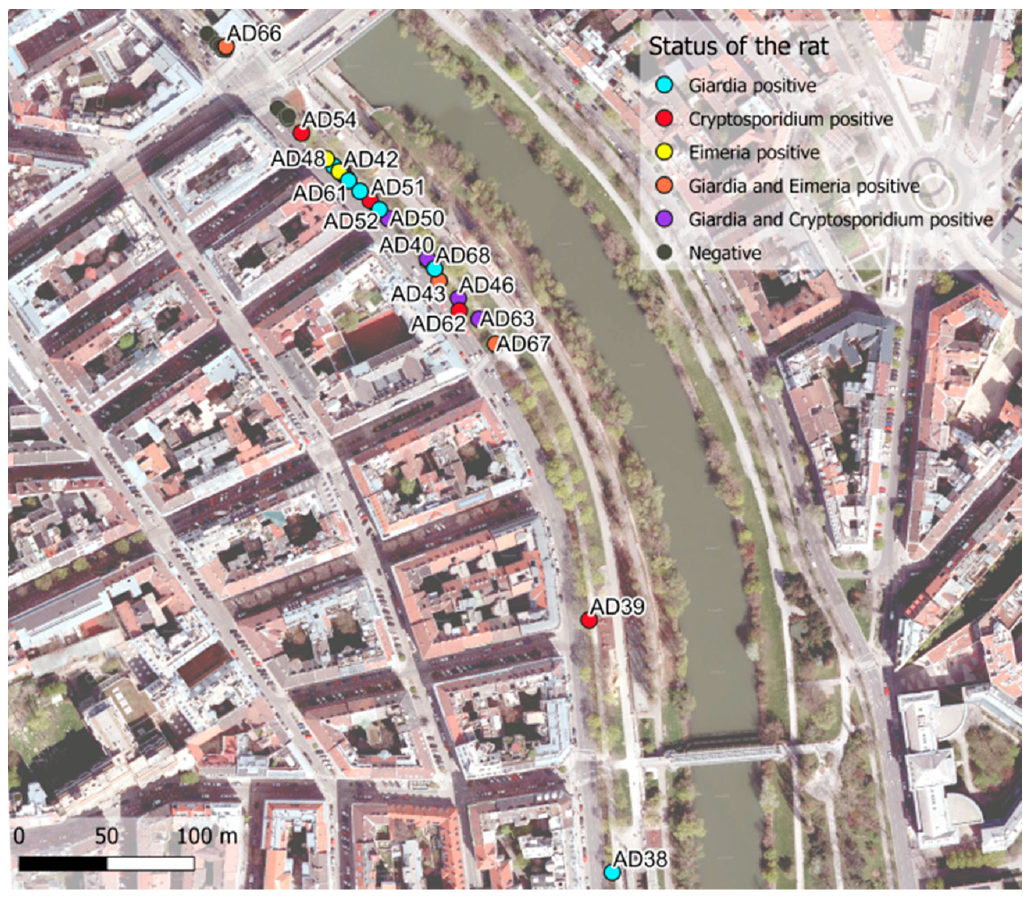
Figure 1. Spatial distribution of the trapped urban brown rats ( R. norvegicus ) at the Danube Canal, March-June 2017, Vienna, Austria. Parasite-positive rats are labeled. Rats trapped were sequentially named AD31–84.